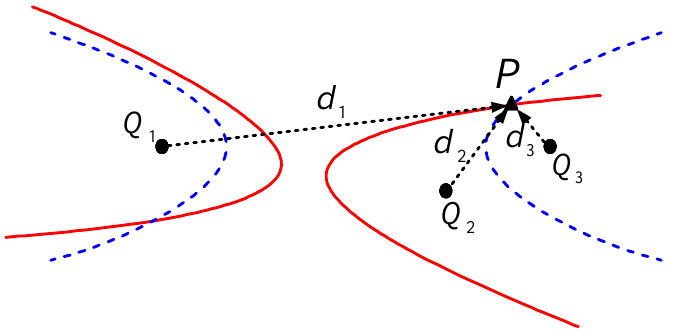
Figure 2. Principle of impact location determination based on hyperbolic equations.